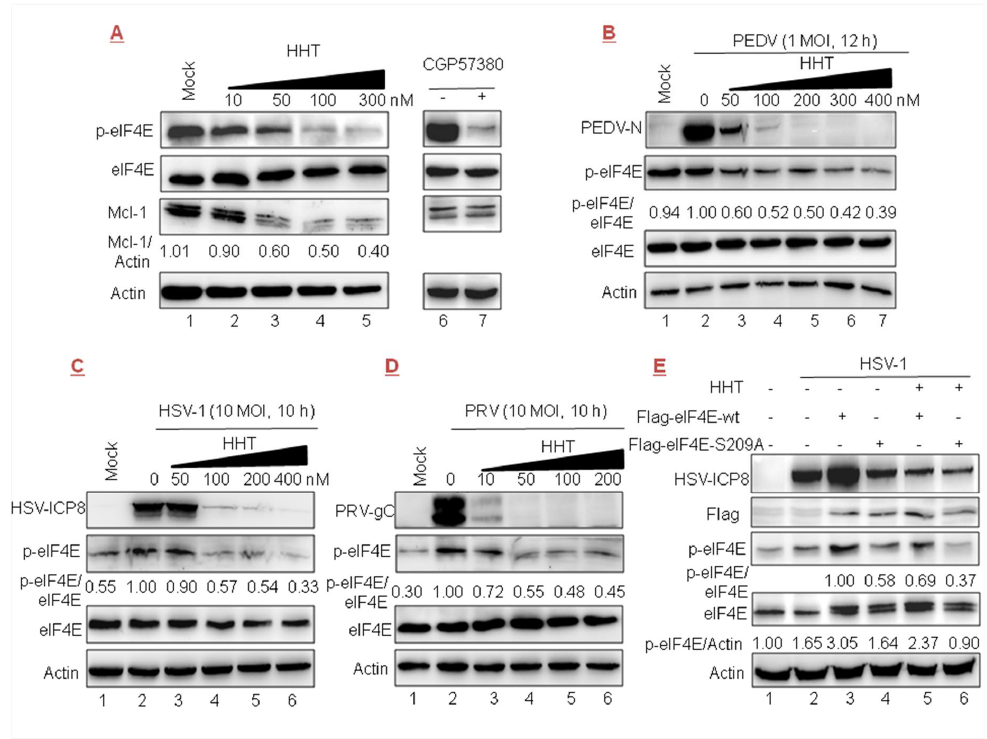
Figure 6. HHT regulates the phosphorylation levels of eukaryotic initiation factor 4E (eIF4E). ( A ) Vero cells seeded at 2.5 × 10 6 cells per well in six-well plates were treated with increasing doses of HHT for 24 h. Electrophoretically separated proteins were analyzed by Western blotting using antibodies directed against phosphorylated eIF4E (p-eIF4E), eIF4E, and Mcl-1, with actin as a control. ( B – D ) Vero cells were mock infected (lane 1) or infected with PEDV (panel B ), HSV-1 (panel C ), or PRV (panel D ) for 12, 10, or 10 h (lanes 2–6) in the presence of HHT at different concentrations. Electrophoretically separated proteins were analyzed by Western blotting using antibodies directed against p-eIF4E, eIF4E, PEDV-N, HSV-ICP8, PRV-gC, and actin. Densitometry analyses were quantified using the ImageJ software. ( E ) HeLa cells in a T-25 flask were transfected with FLAG-tagged eIF4E (lanes 3,5) or eIF4E-S209A plasmid (lanes 4,6) (5 µ g each), in the absence (lanes 1–4) or presence (lanes 5,6) of HHT at 100 nM, then mock infected (lane 1) or infected with HSV-1/F at 10 MOI for 10 h (lanes 2–6). Cell lysates were then analyzed by Western blotting with the indicated antibodies. One of two independent experiments is